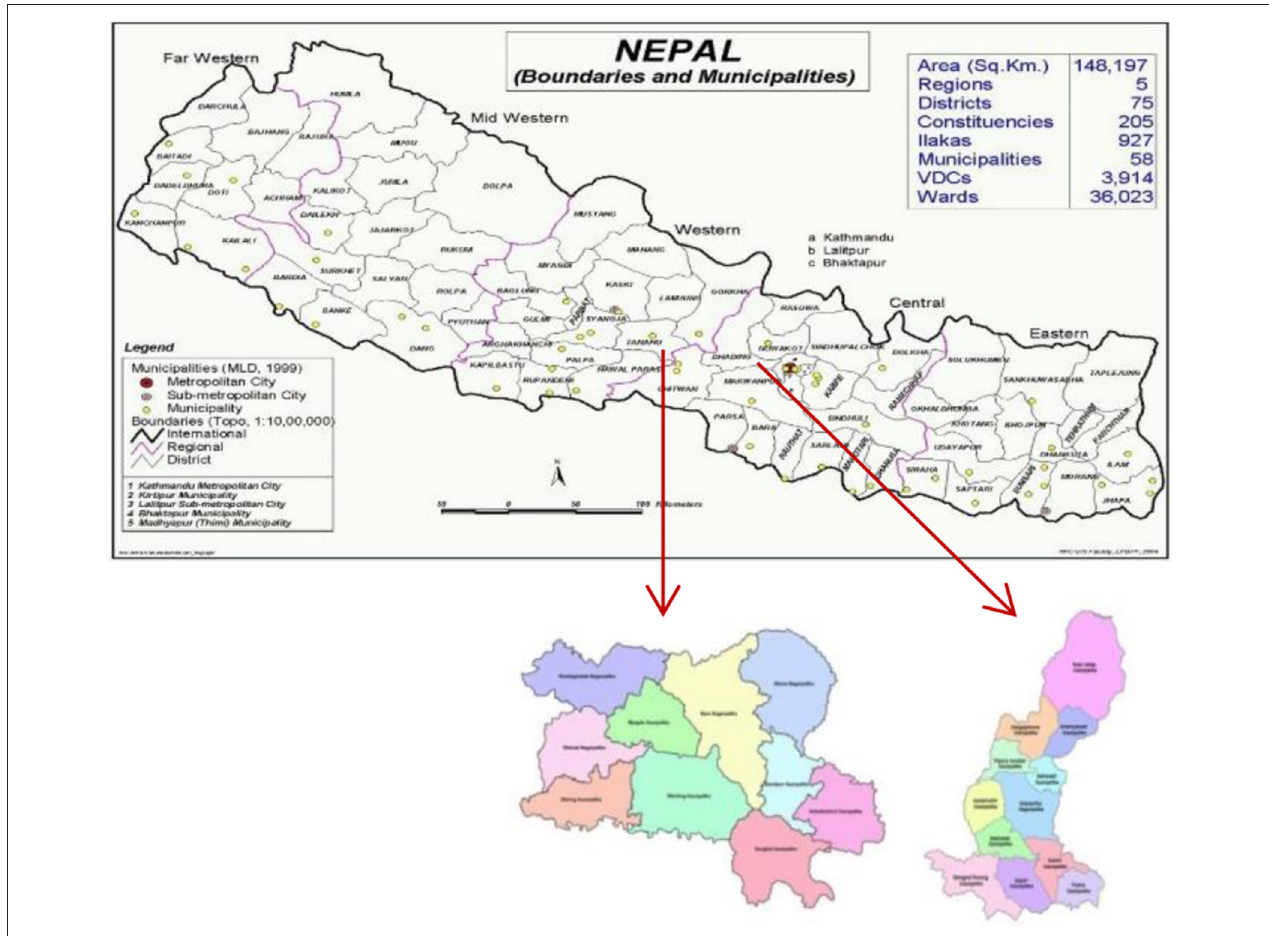
FIGURE 1 | Case study sites. Retrieved from ReliefWeb and Kathmandu